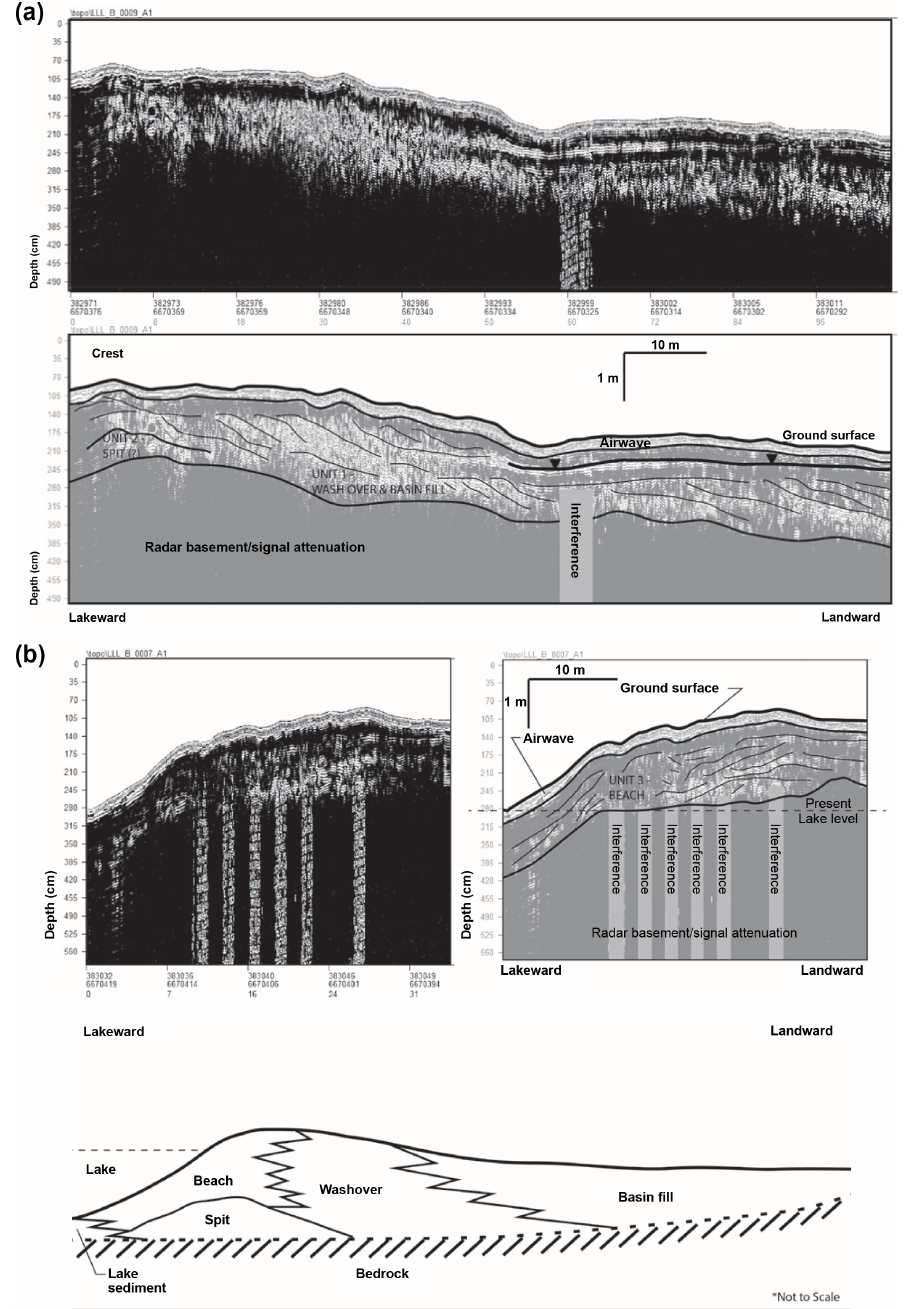
Figure 2. (a) GPR transects over the “berm”. See Fig. 1 for location of transect. GPR line A7 was acquired perpendicular to the shoreline starting just lakeward of the highest point on the berm. Internal structures are characteristic of an interfingering beach–wash-over–basin fill sequence over a spit complex. Upper panel, raw data; lower panel, interpretation. (b) GPR line A9 was acquired from the lake shore to the highest point on the berm. Internal structures show characteristics of a beach environment over a spit complex. Top left panel, raw data; top right panel, interpretation. The lower panel shows a conceptual model based on composite GPR profiles suggesting a lower lake facies with spit facies underlying beach, wash-over, and basin fill